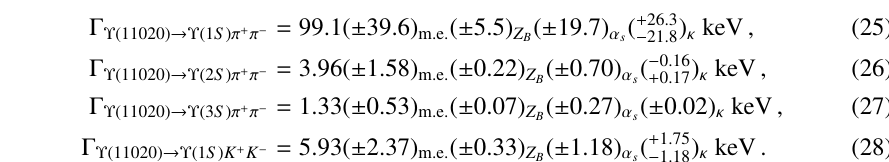
Figure 4. The single and double lines represent quarkonia in singlet and octet states respectively. The curly line stands for a gluon. Note that the spectator gluons forming the H n state are not displayed.